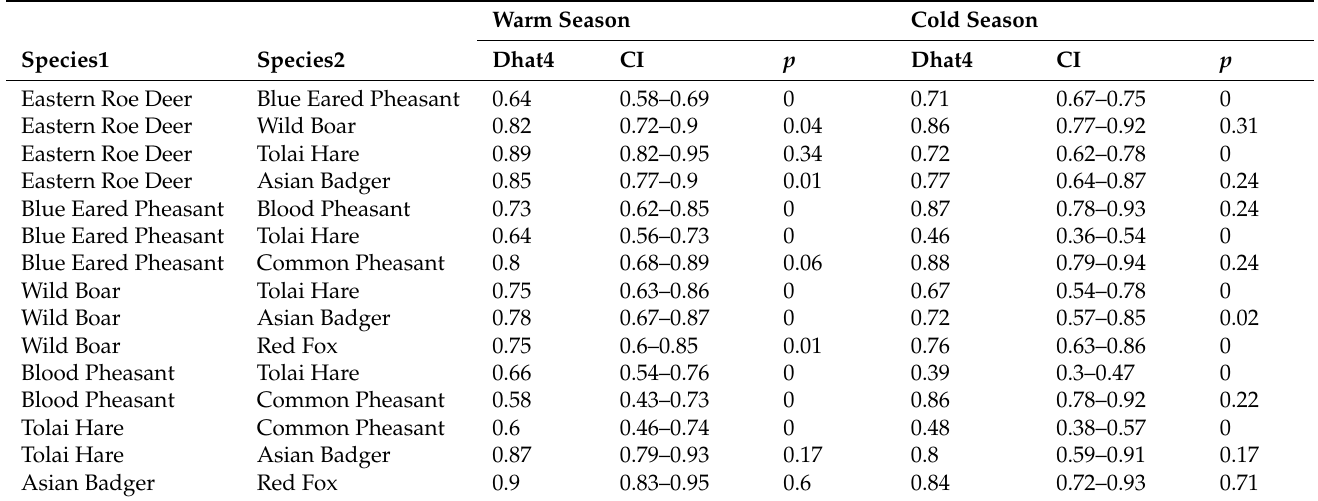
Table 4. Coefficients of daily activity overlapping (Dhat4), confidence intervals (CI) and p -level ( p ) for competitor species on the eastern Qinghai-Tibet Plateau in